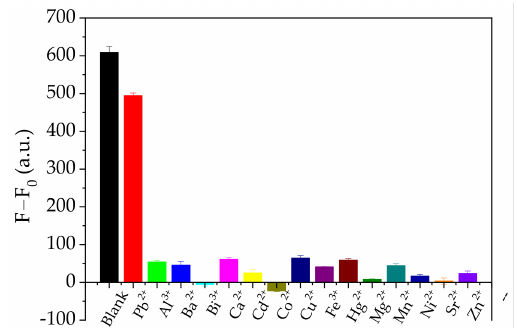
Figure 9. Selectivity of the assay for various metal ions.